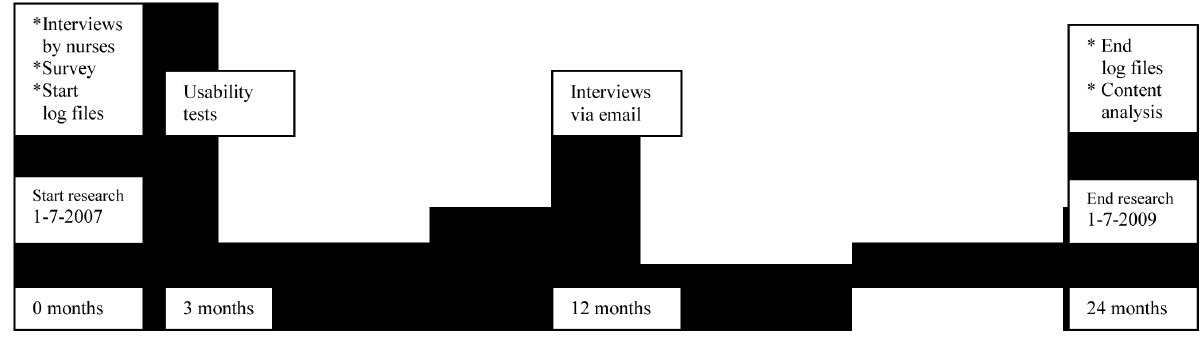
Figure 1. Chronology of the data collection